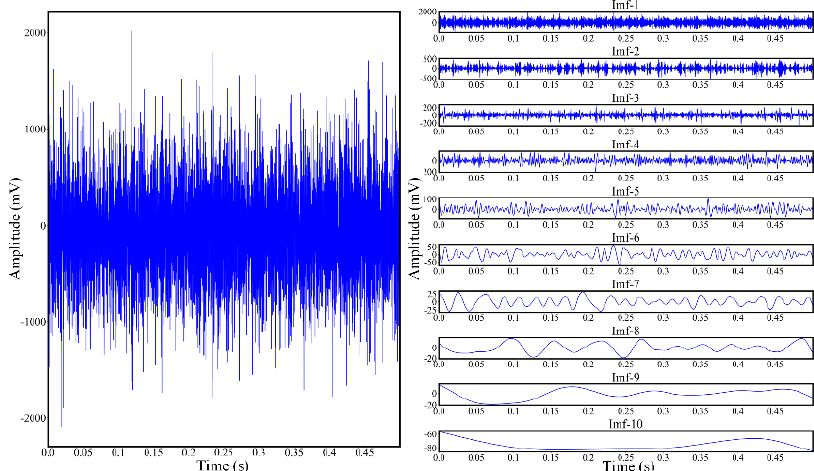
Figure 7. Raw signal and decomposed Imfs under the outer-race fault.